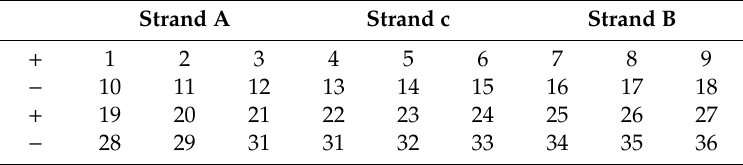
Table 1. Tingley plan of a single-layer integral-slot winding (N1 = 36, p = 2, m = 3). Strand A Strand c Strand B + 1 2 3 4 5 9 − + 1